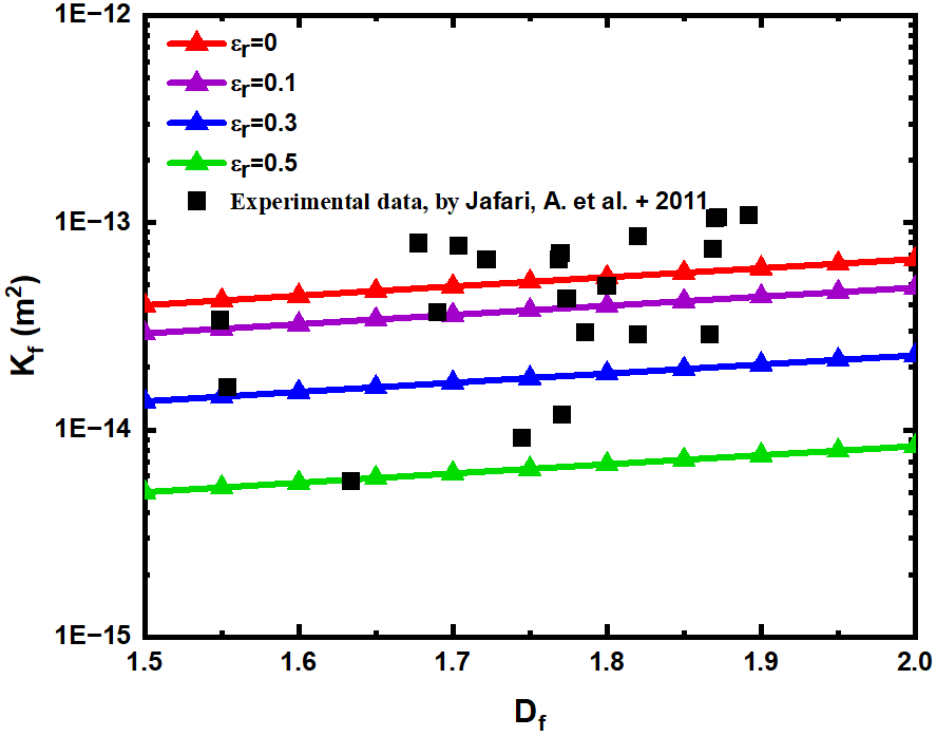
Figure 7. Comparison of permeability model prediction of rough fracture network and numerical simulation results [50].